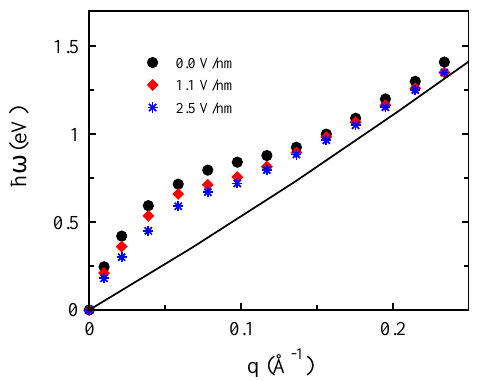
Figure 7. The gate voltage dependence of the plasmon mode in bilayer graphene. The values of the gate voltages are 1.1 V/nm and 2.5 V/nm related to band gaps of about 0.1 and 0.2 eV, respectively.